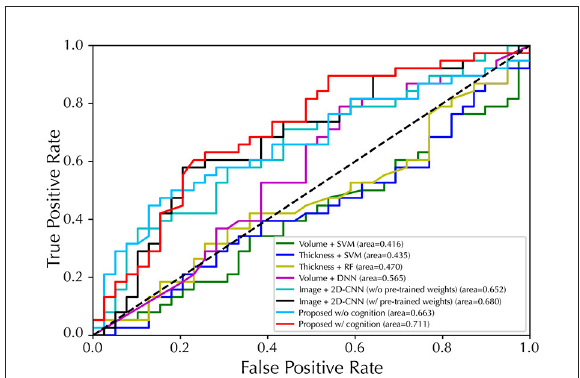
FIGURE3 Performance of ROC curves for EP/HC classification with five-fold cross-validation. The proposed model used GM map as input.